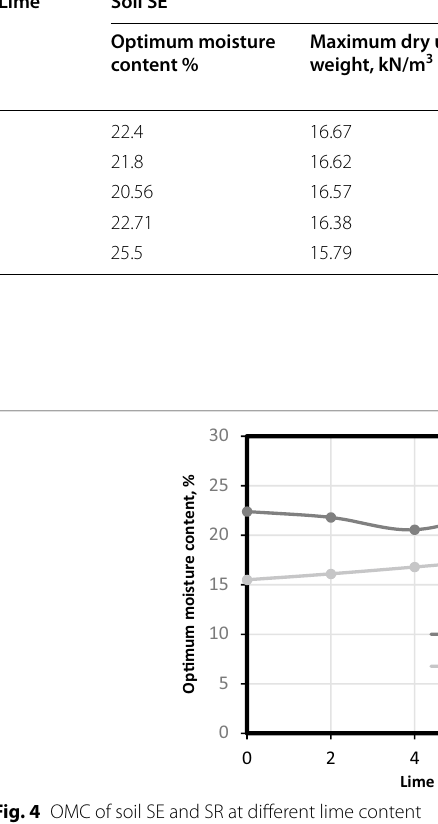
Table 6 Optimum moisture content and maximum dry unit weights for soils SE and SR % Lime